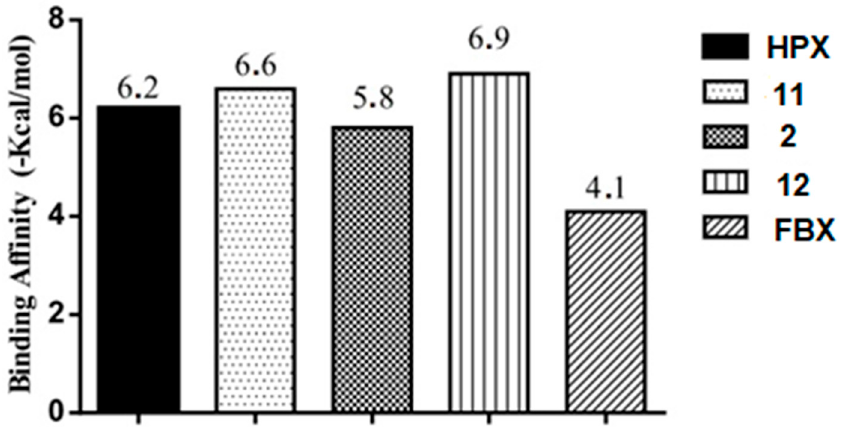
Figure 8. Binding affinity provided by AutoDock/Vina software of the compounds 11 (Gallic acid), 2 (Quercetin) and 12 (Foeniculin) and control ligand febuxostat (FBX). Ligand complexed hypoxanthine (HPX) for XO (organism Bos taurus ).